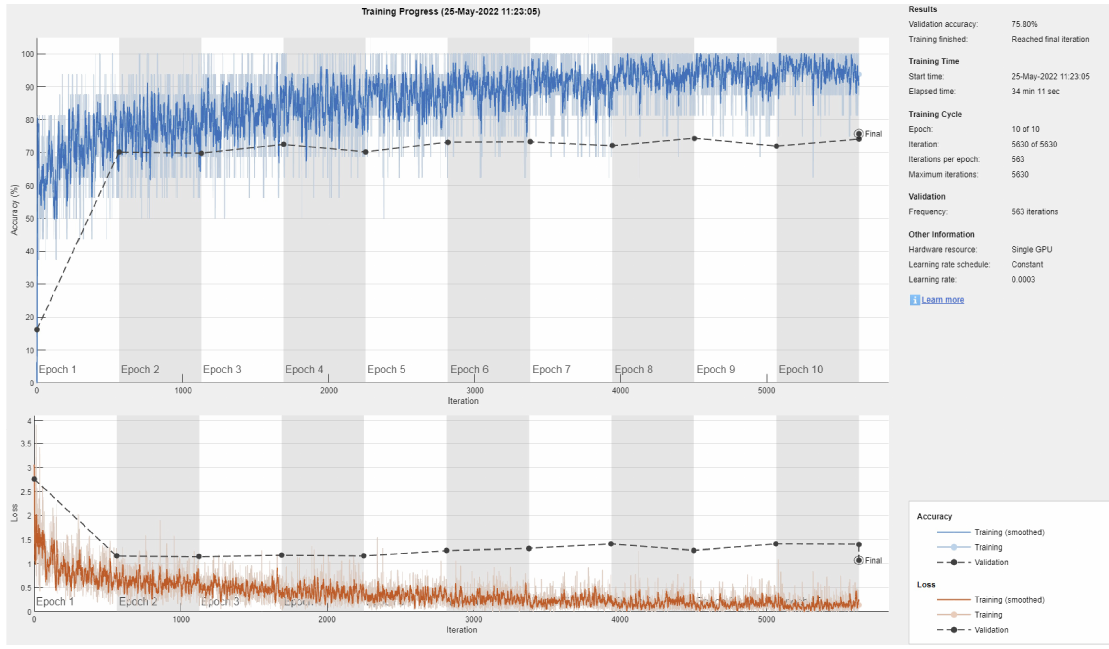
Figure 7. Sample training/validation progress curve for DarkNet-53 and 90/10 data